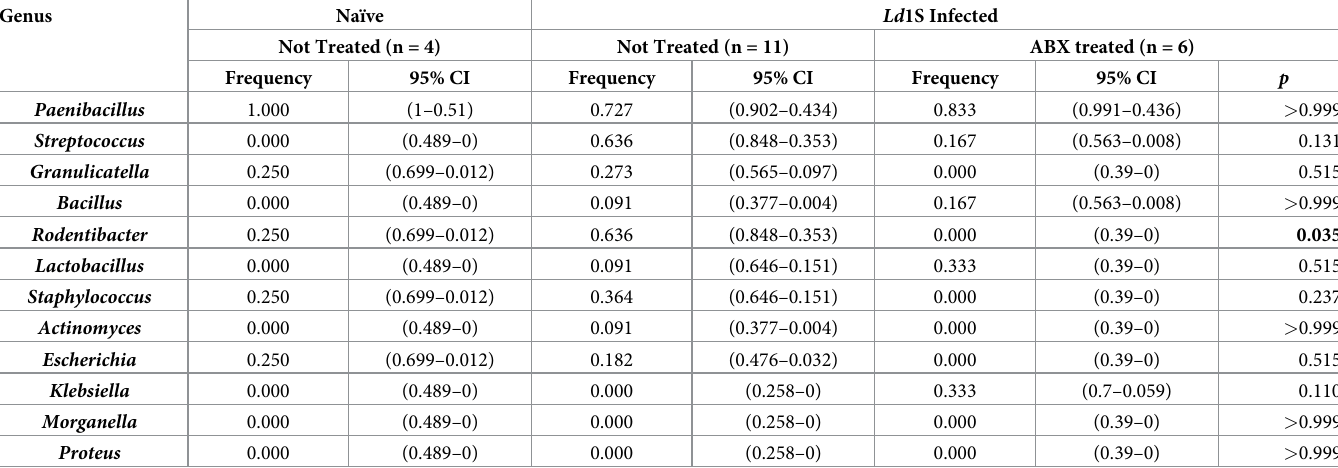
Table 1. Frequency of live bacterial genera isolated from hamster liver